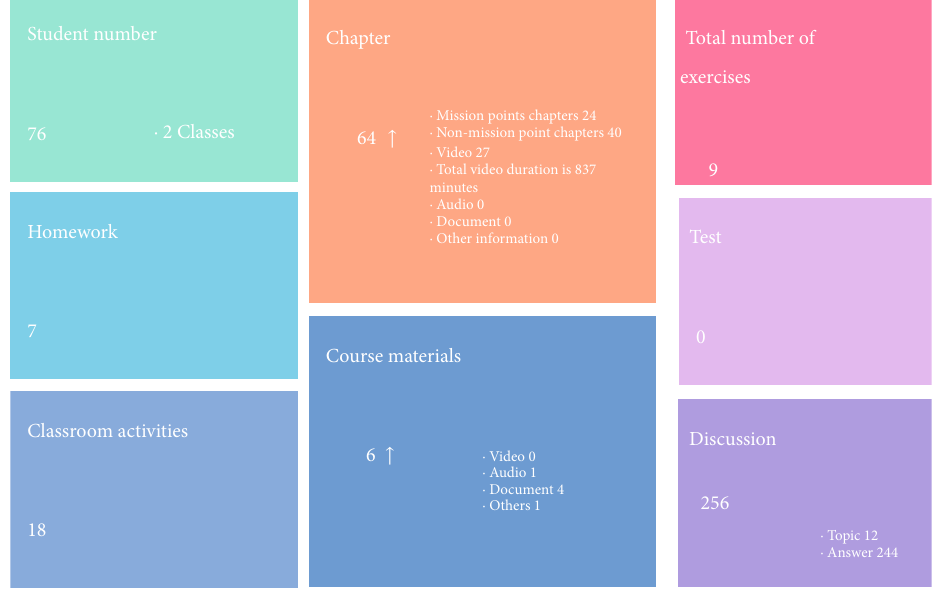
Figure 1: The console webpage of the Chaoxing Xuexitong